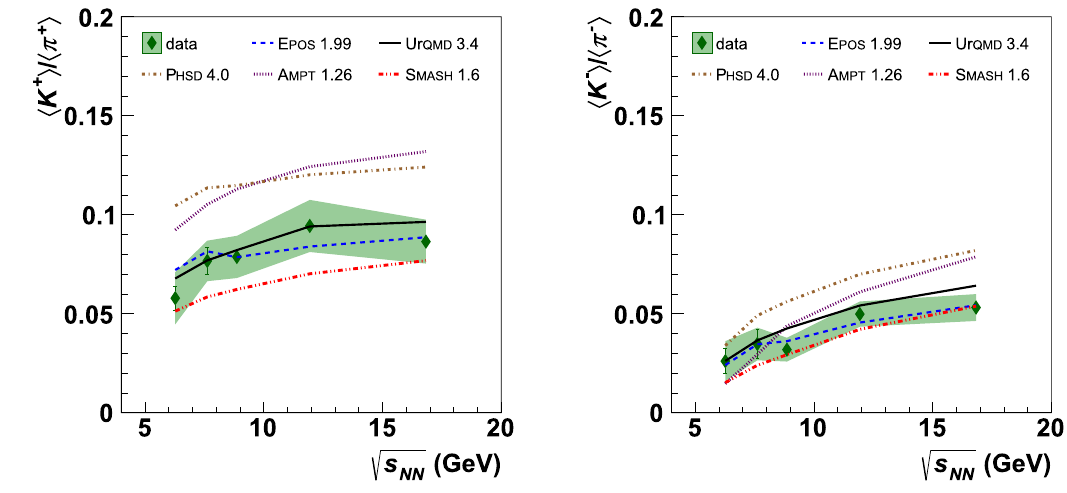
Fig. 38 Comparison of the energy dependence of K + / π + (left) and K − / π − (right) mean multiplicities ratio for the 20% most central Be+Be collisions with models: Epos 1.99 (blue dashed line), U r